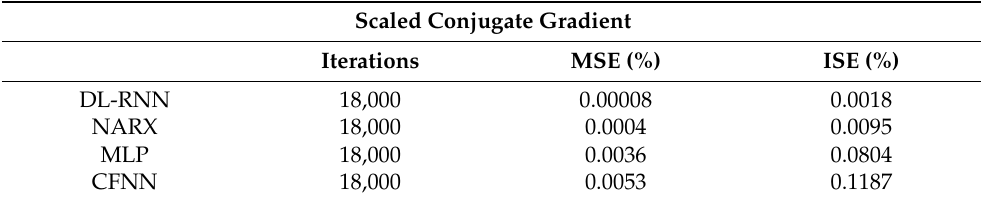
Table 7. Results of testing (SCG algorithm, Challenge dataset).